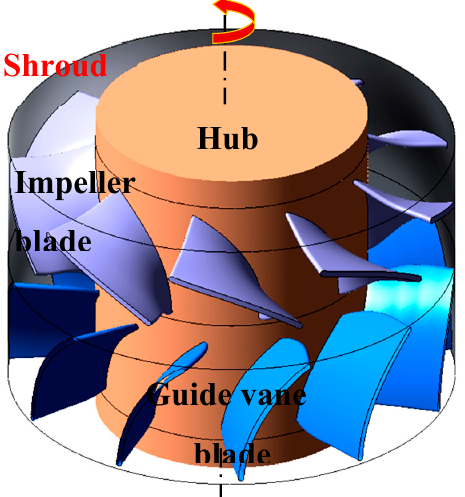
Figure 1. Axial-flow fan model.